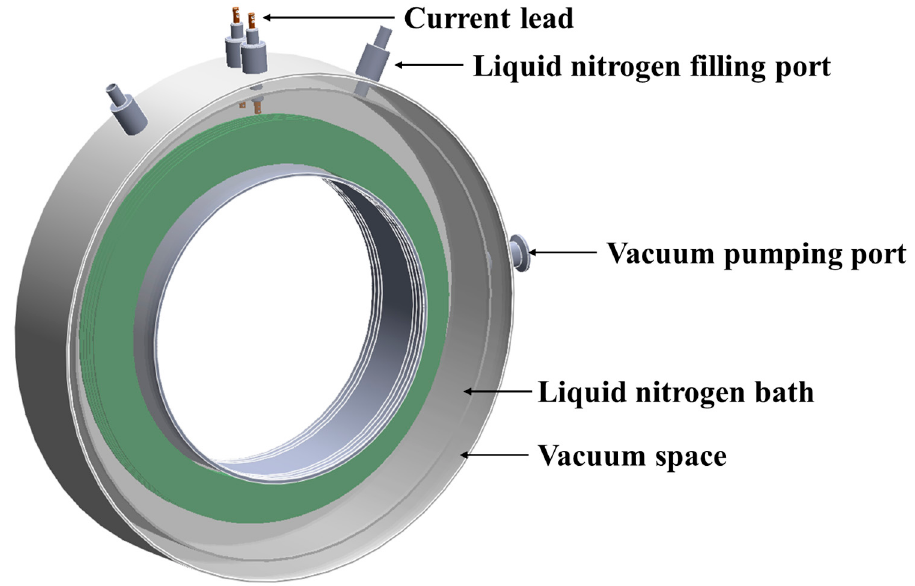
Figure 11. Liquid nitrogen (LN2) cryostat for the HTS field coil.